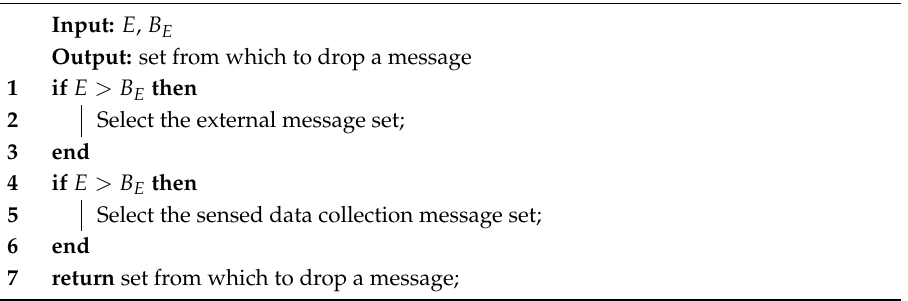
Algorithm 2 The algorithm for selecting the message set from which to drop a